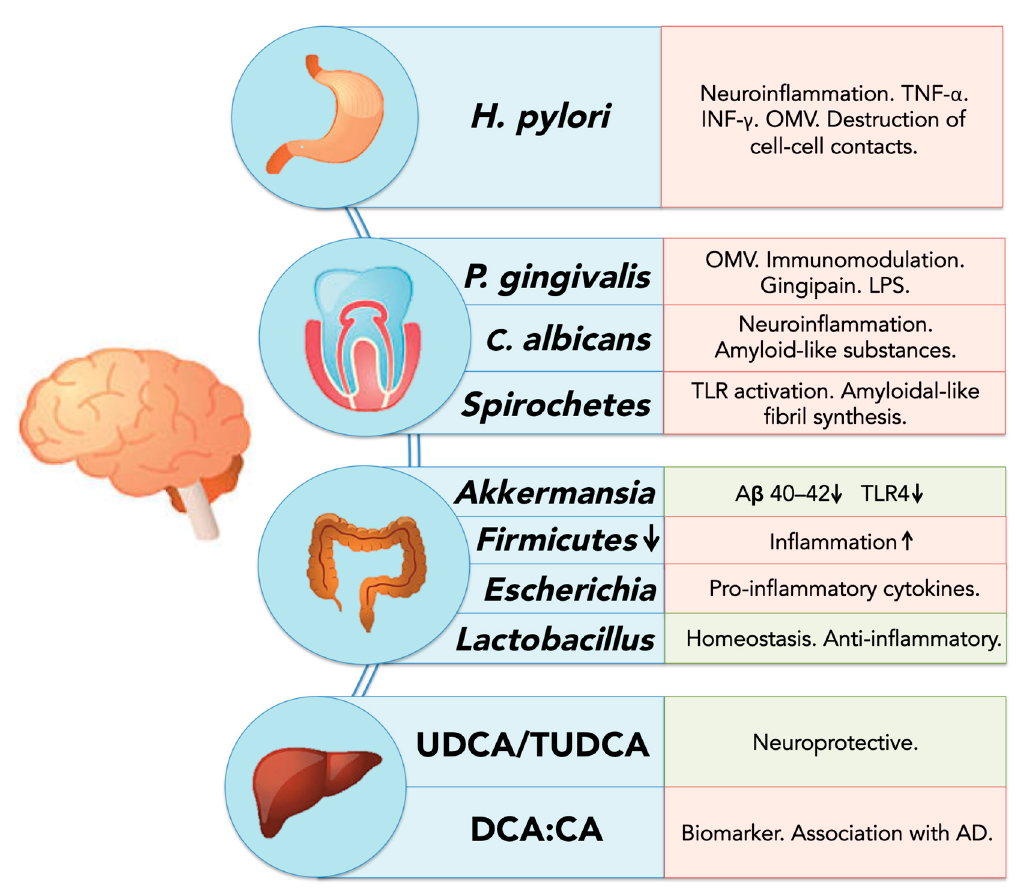
Figure 2. Schematic overview of microbiome-associated factors influencing neurodegenerative diseases. Factors are displayed according to their organ of origin (stomach, oral cavity, colon and liver); positive effects on neurodegenerative diseases are displayed in light green, negative effects in light red.